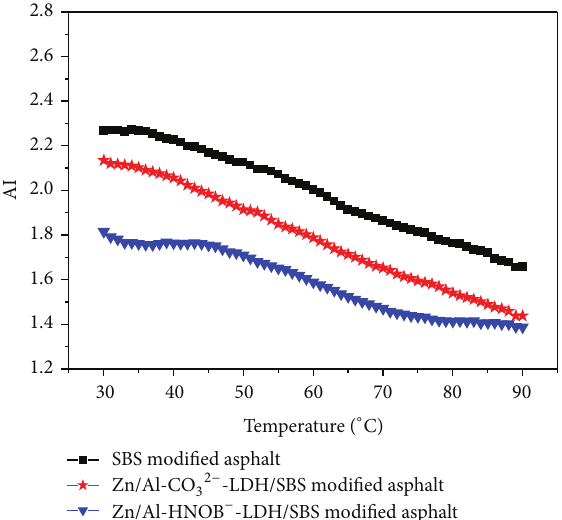
Figure 10: AI values of SBS modified asphalt, Zn/Al-CO 32− -LDH modified asphalt, and Zn/Al-HNOB − -LDH/SBS modified